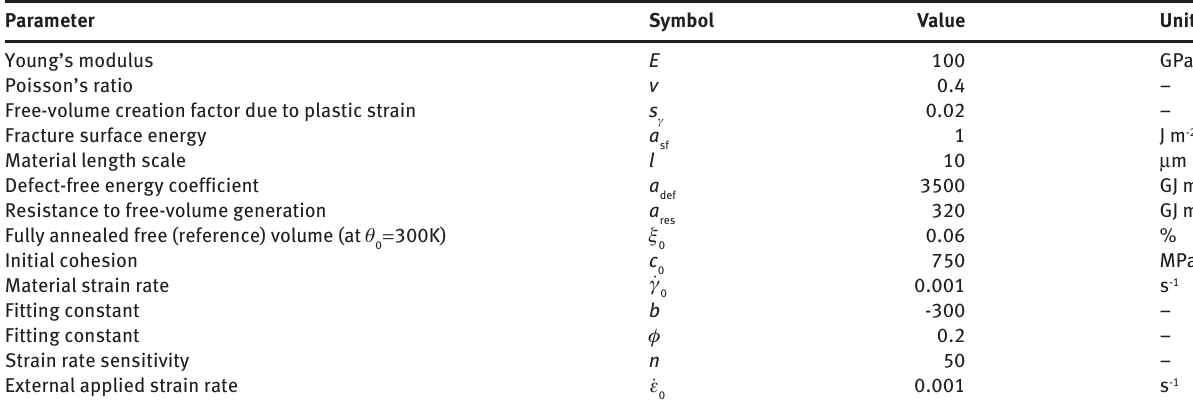
Table 1 Material parameter values adopted for the mathematical model.